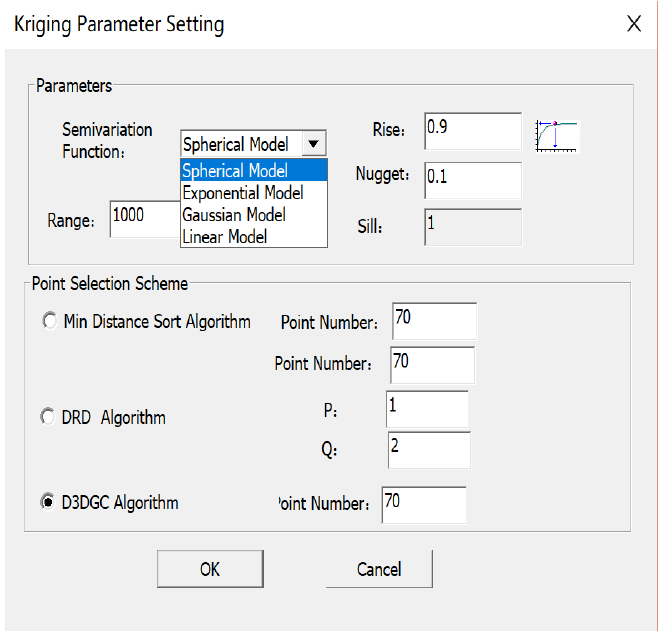
Figure 8. G3D data generation.